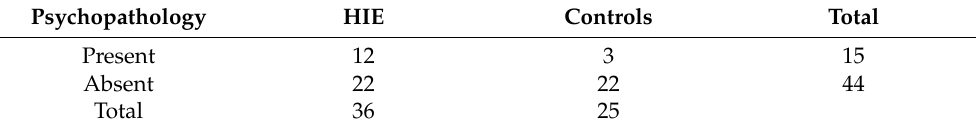
Table 2. Cross-tabulation of children and controls with HIE with present or absent psychopathology.